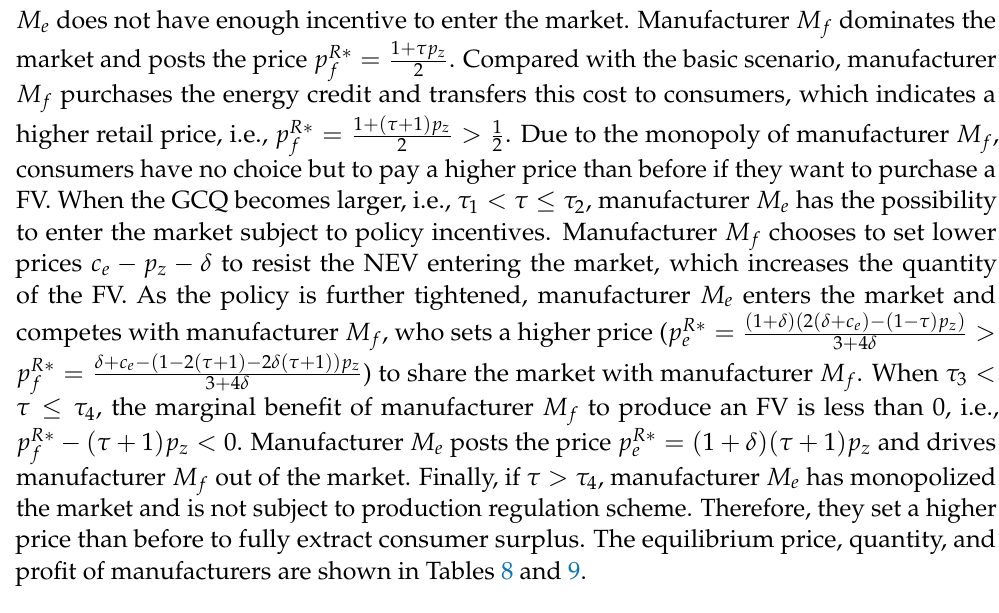
Table 8. Equilibrium price and quantity under the production regulation scenario.